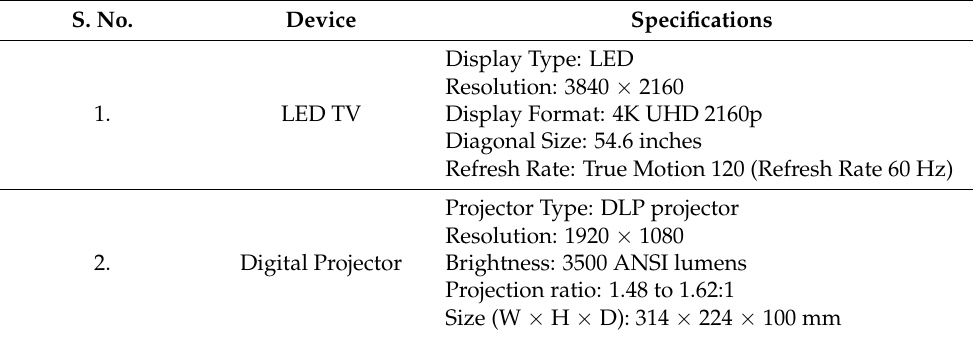
Table 2. Some of the specifications of the LED TV and DLP projector used for experiments. S. No.